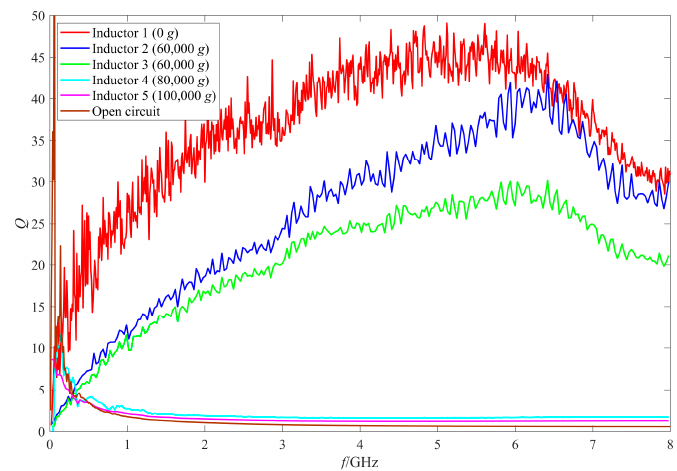
Figure 15. The Q factors of the inductors after shock test with different shock amplitude.